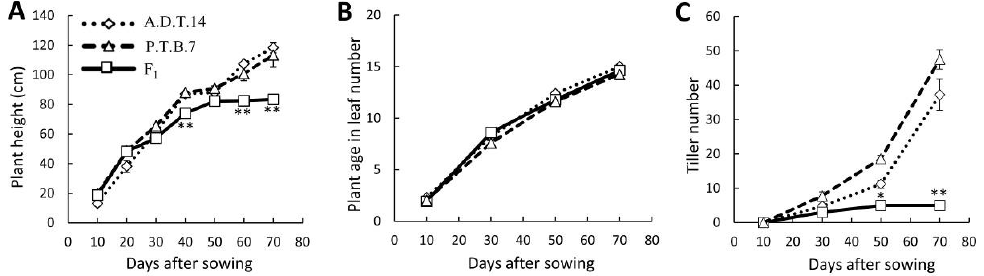
Figure 2. Phenotypic traits of parental and F 1 hybrid rice. ( A ) plant height; ( B ) plant age in leaf number; and ( C ) tiller number. Values and error bars indicate mean ± SE values ( n = 5), although some error bars are hidden by the symbols. Mid-parental and hybrids values were compared using two-tailed Student’s t-test. Significance: ** P < 0.01, * P < 0.05.